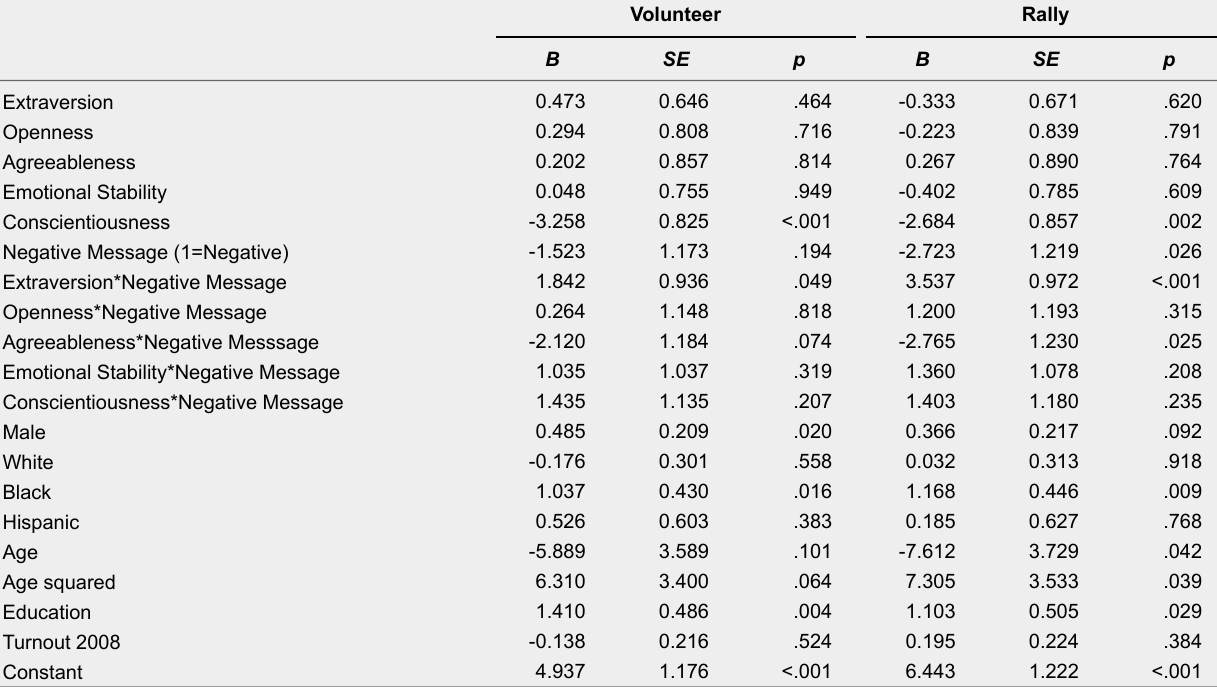
Linear Regression Models (OLS) of Political Participation, Volunteer and Rally Intentions (N =